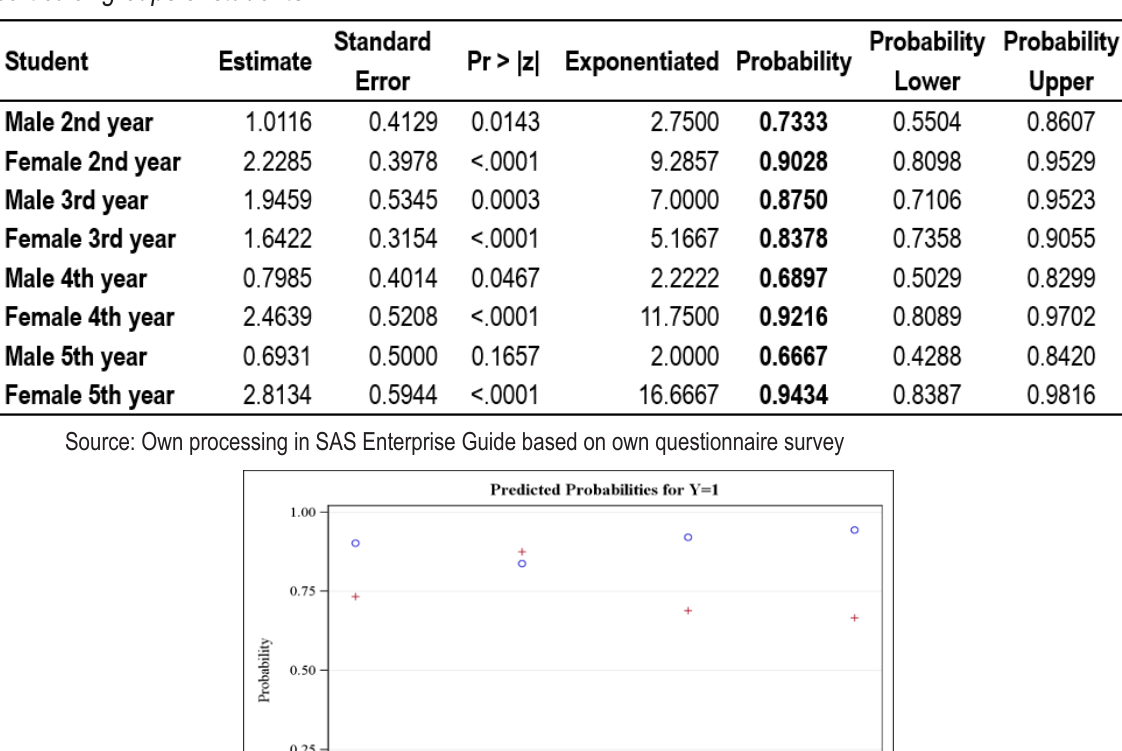
particular groups of students